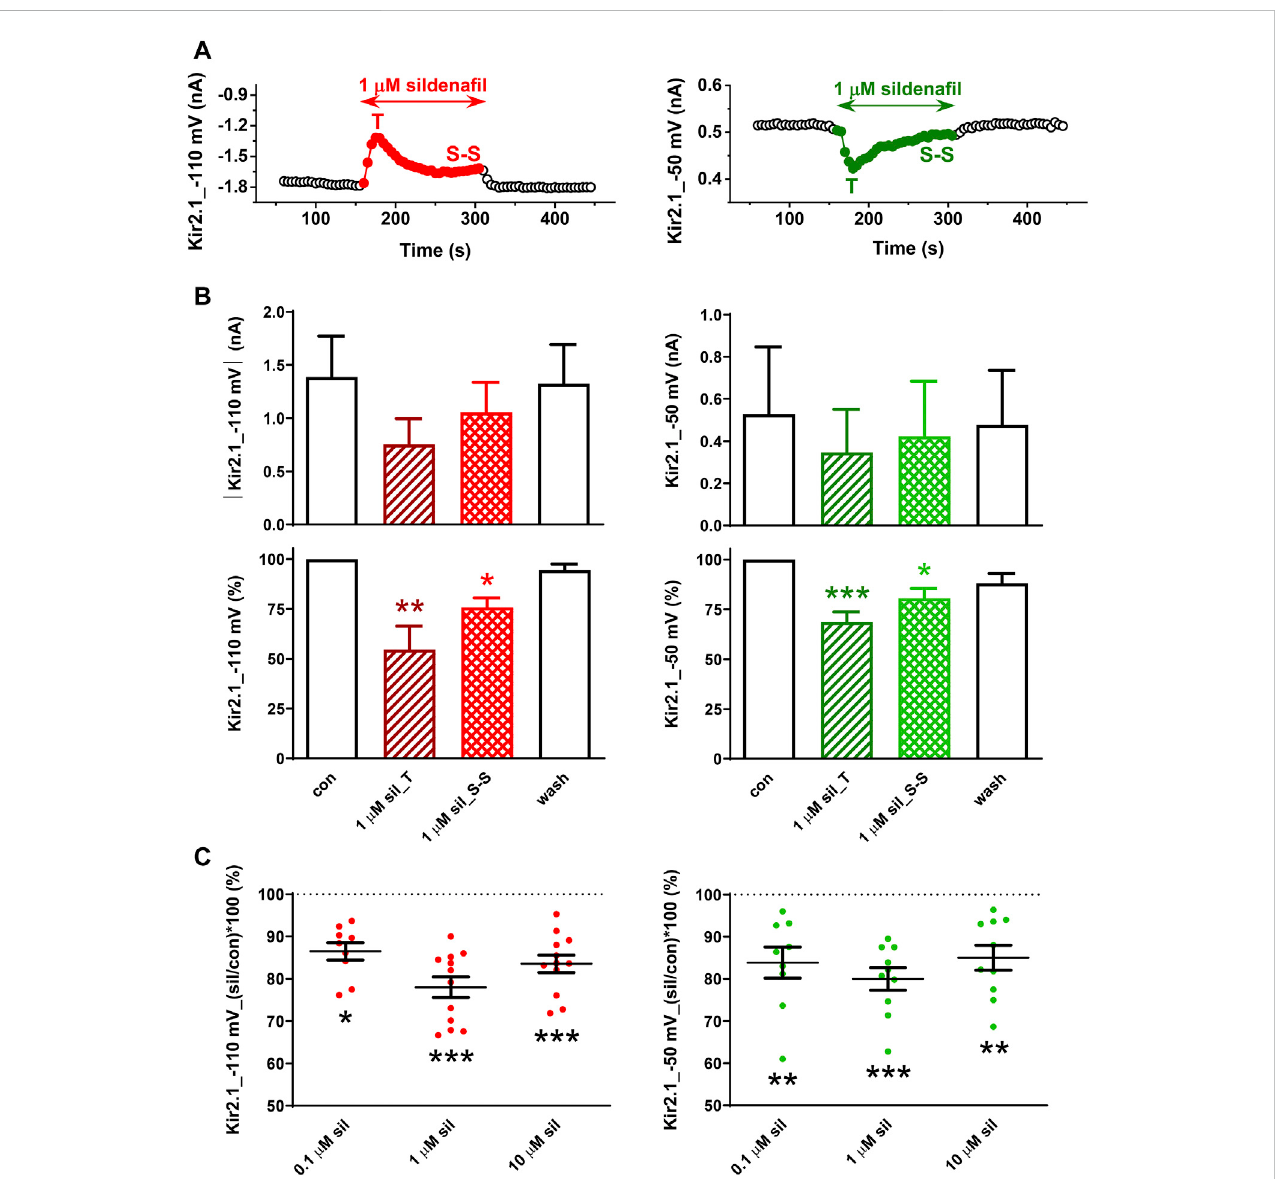
Effect of sildena fi l on the human Kir2.1 channels. (A) Representative time courses of Kir2.1 changes in control (con), during application of 1 µM sildena fi l (sil), and during thesubsequent wash-out (wash);T — transienteffect, S-S — steady-state effect. (B) Kir2.1 current and itsaverage changes under1 µM sildena fi l ( n =6). (C) Concentrationdependenceofthesteady-state effectof sildena fi lon thehuman Kir2.1( n =9 – 12); *,**,and*** — statisticalsigni fi canceat p < 0.05, 0.01, and 0.001, respectively.